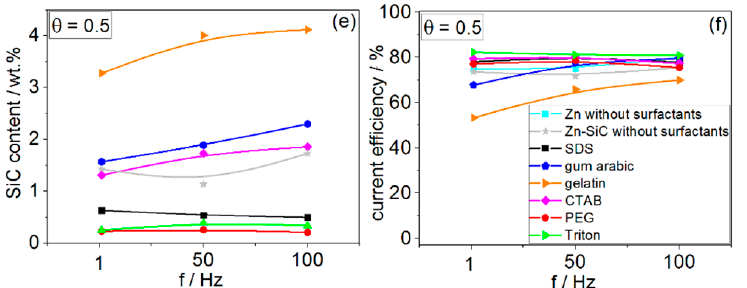
Figure 7. The effect of frequency in PED from electrolyte solutions with or without organic additives on the SiC content in Zn–SiC deposit ( a , c , e ) and on the faradaic efficiency of the PED process ( b , d , f ) at different values of duty cycle.